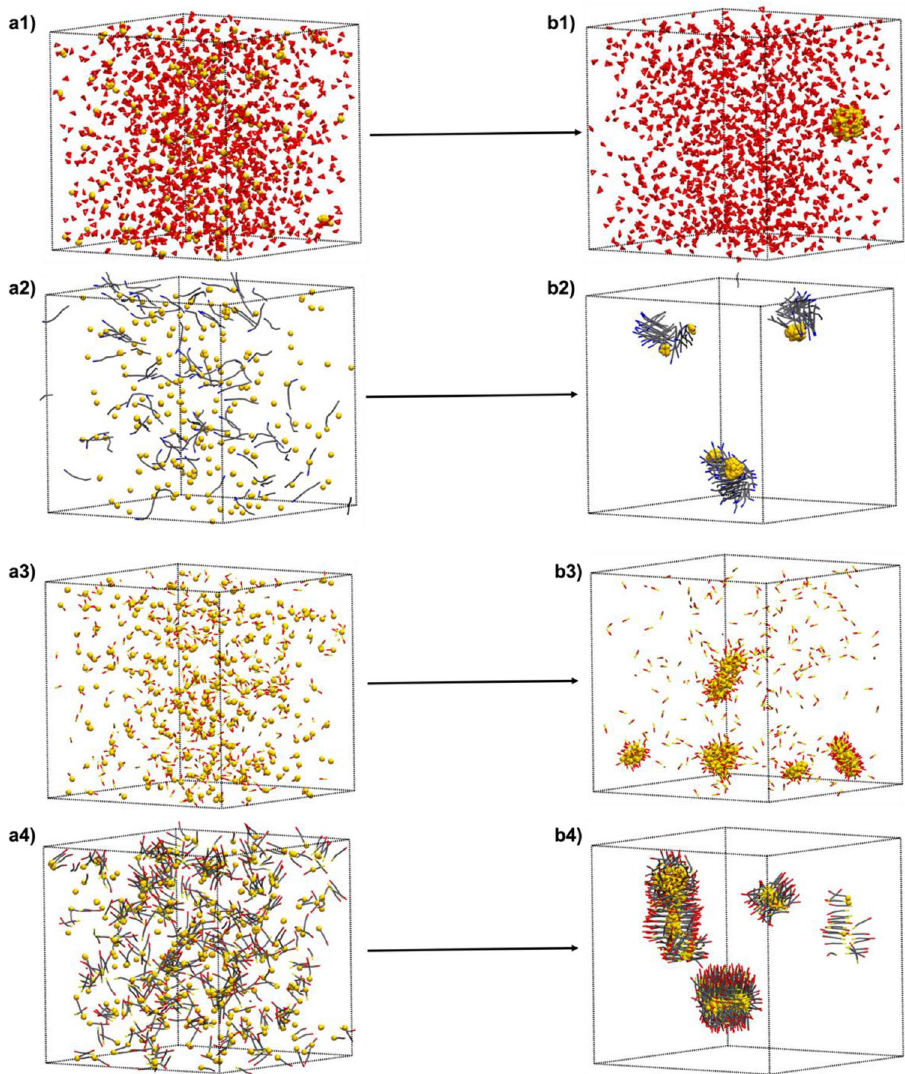
Figure 3. The initial point for all simulations is observed on the left (from a1 to a4 ), and the final structures obtained after 1.35 μs are shown on the right (from b1 to b4 ). ( a1 , b1) contain 500 golds beads mixed with 1350 citrate molecules at higher working temperature (373 K). ( a2 , b2 ) are obtained when 333 gold beads were mixed with 110 N-type surfactants. ( a3–b3) and ( a4–b4) contain 500 gold beads and 650 S-type surfactants (1/2.6 molar ratios). MPA molecules ( a3–b3 ) are formed by two different beads (O-type and S-type), while MUA molecules ( a4–b4 ) contain four beads. The lengthening of the surfactant can cause different effects such as the deformation of Au NPs. Note that hydrocarbon chains want to stay closer for minimizing their interaction with solvent. Gold beads and citrate molecules are represented by CPK drawing, while N-type and S-type molecules are represented using Licore drawing method. Water molecules are removed for